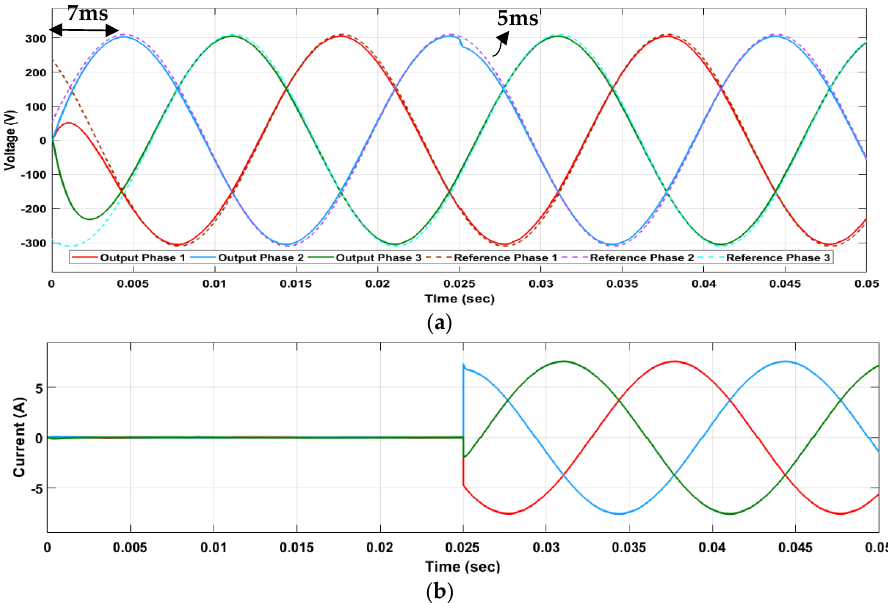
Figure 7. ( a ) RRL [29], output voltage-reference tracking trajectory and voltage regulation. ( b ) RRL [29], load current-step response under extreme load variation.